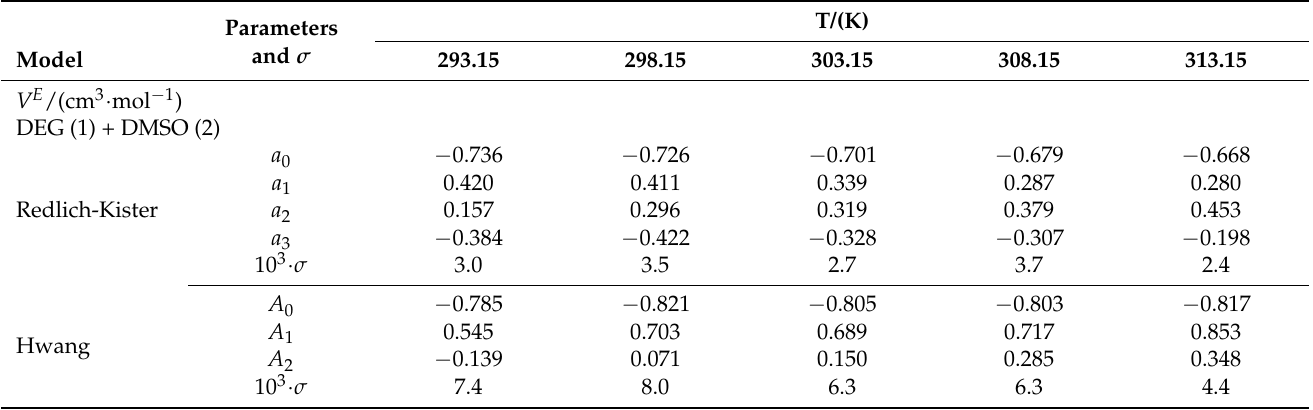
Table A4. Polynomial coefficients 1 and standard deviations ( σ ) for the binary systems in the temperature range from 293.15 to 313.15